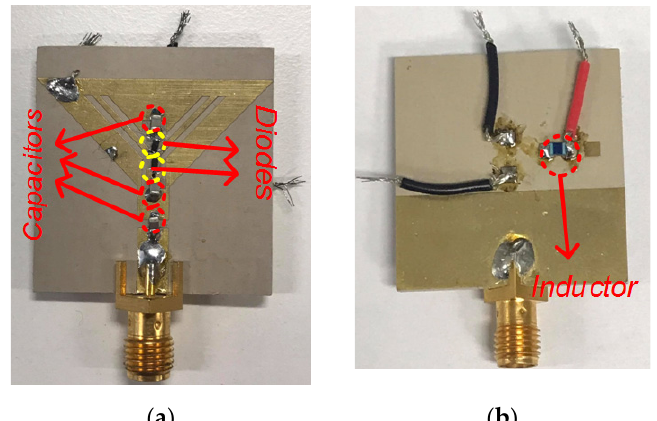
Figure 8. Fabricated prototype of the proposed antenna: ( a ) top-view ( b ) bottom-view